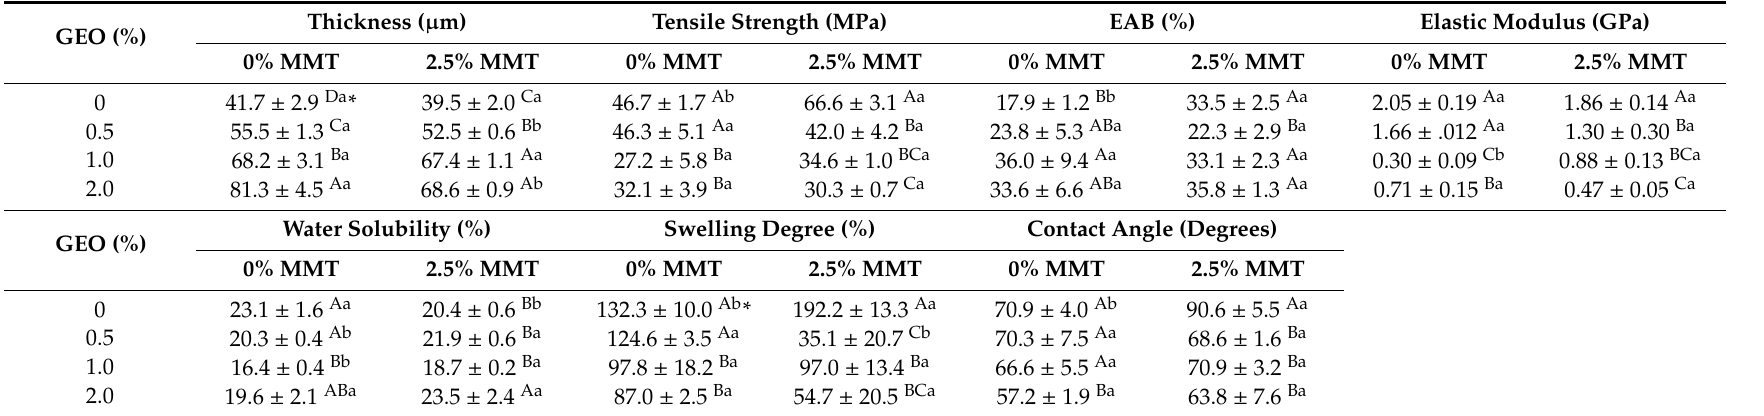
Table 2. Summary of thickness, mechanical properties, contact angle, water solubility and swelling degree of active